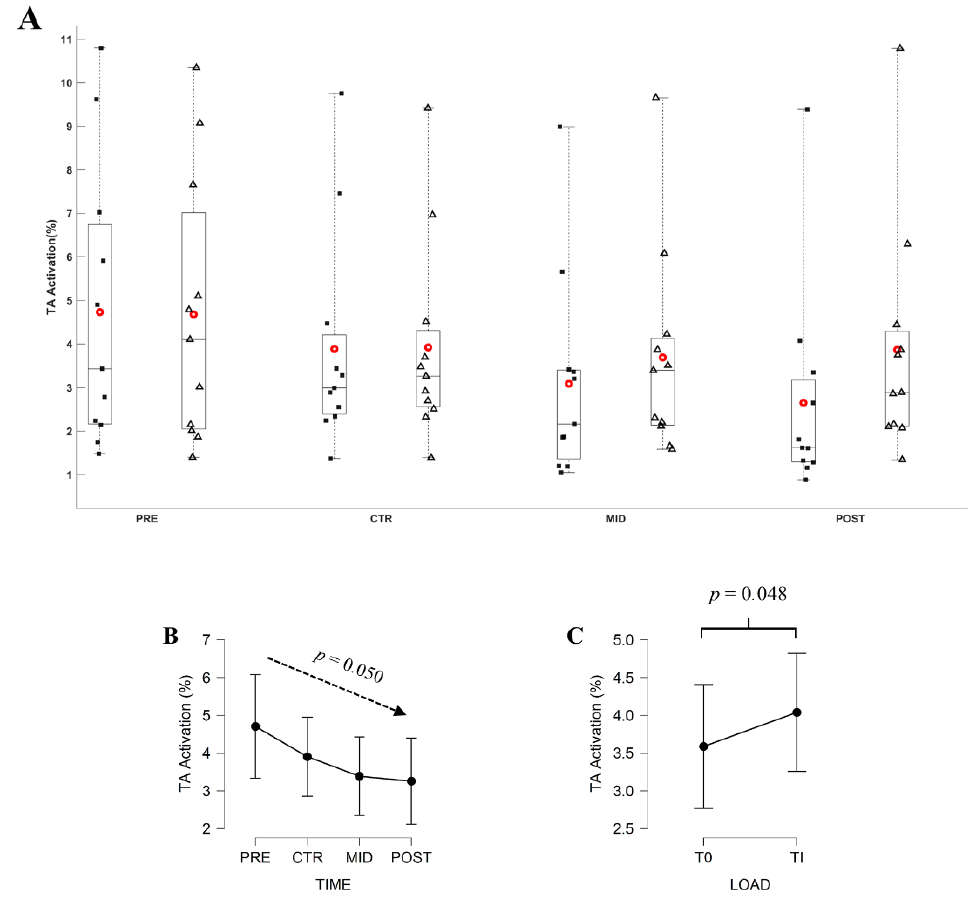
Figure 8. ( A ) Average EMG TA during submaximal contractions computed according to the torque levels, T 0 (black square) and Ti (white triangle), and evaluation sessions (PRE, CTR, MID, POST sessions). Each whiskers box indicates the mean (red circle) and the median (horizontal line). The inferior and superior edges of the box indicate the 25th and 75th percentile, respectively. Black dots represent individual participant performance. ( B ) Average EMG TA during submaximal contractions computed according to evaluation sessions and ( C ) to the torque levels. Error bars represent the most extreme and non-outlier data points ( A ) and 95% confidence intervals ( B , C ).